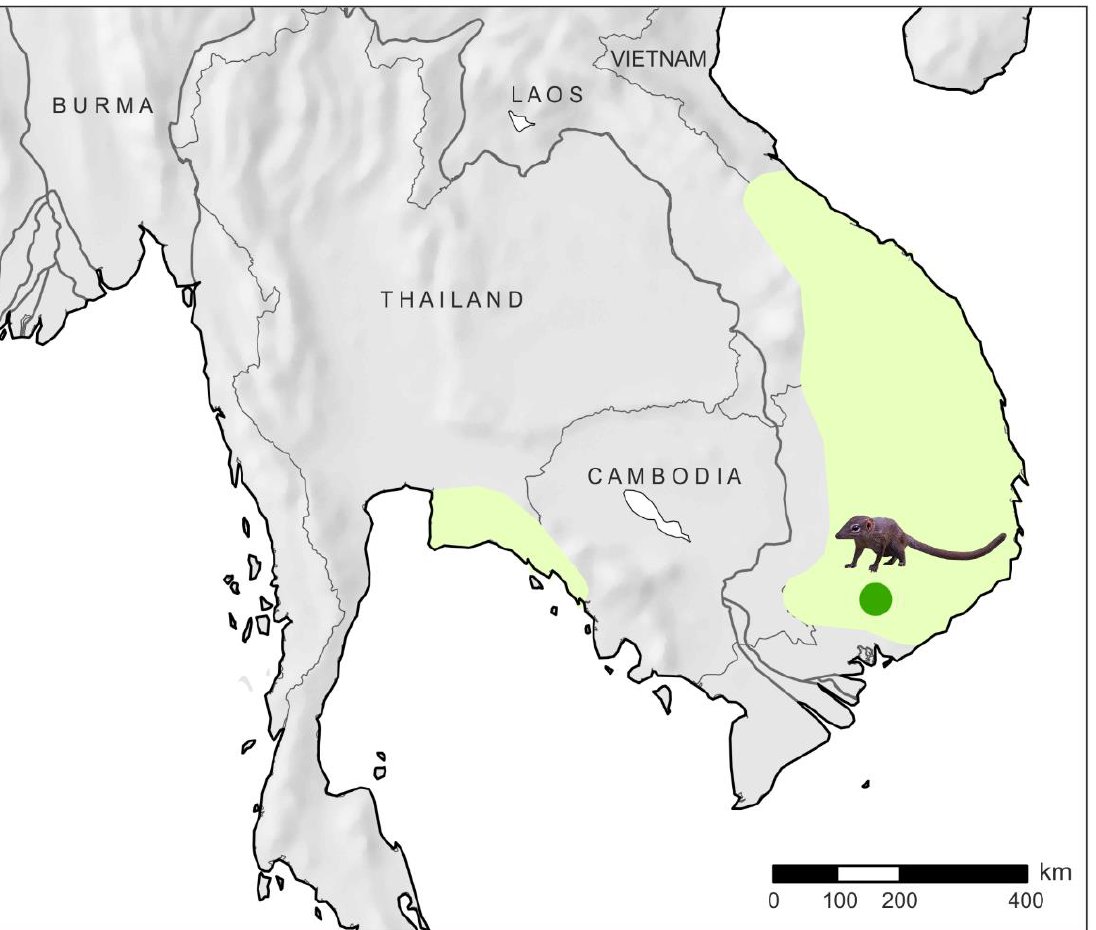
Figure 1. Dendrogale murina distribution range and collection locality. Distribution range is given according to Timmins [15].